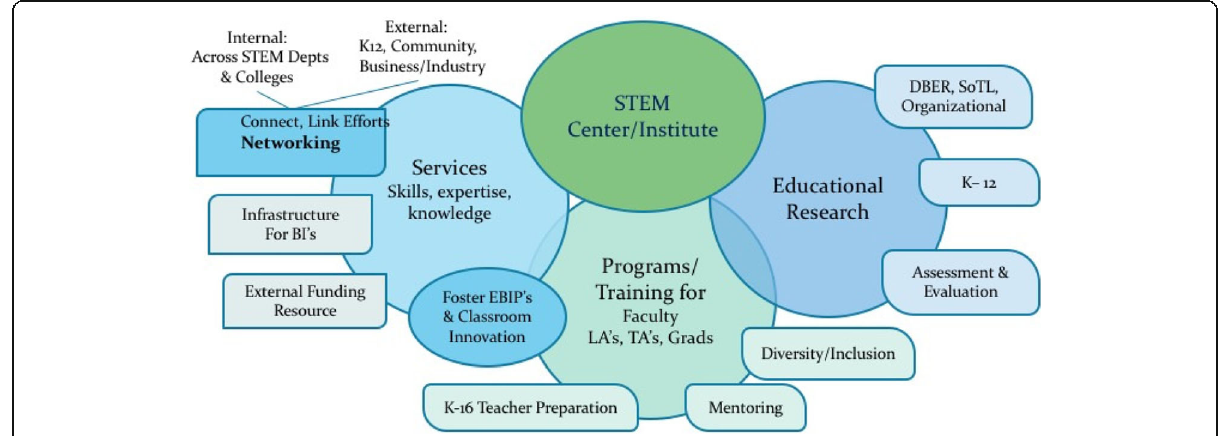
Fig. 3 A model of STEM education center functions/roles